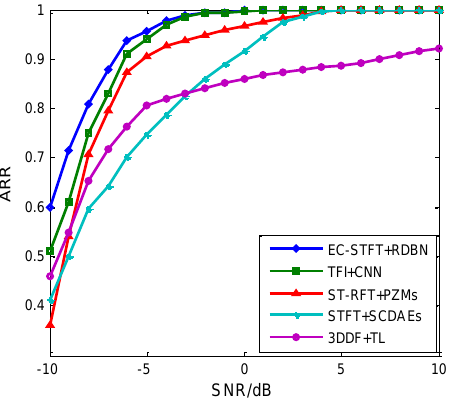
Figure 17. The comparison of different radar emitter intra-pulse signal recognition methods.